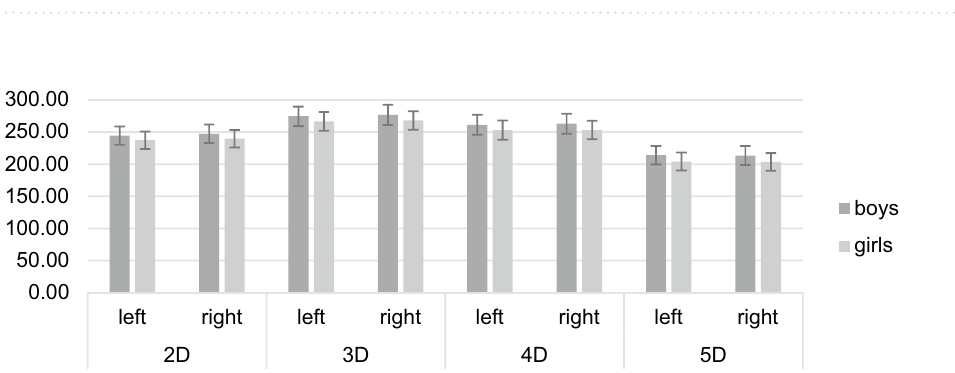
Table 2. Means, standard deviations, post-hoc t -tests, and effect sizes for sex differences in digit lengths of both hands (N = 763).